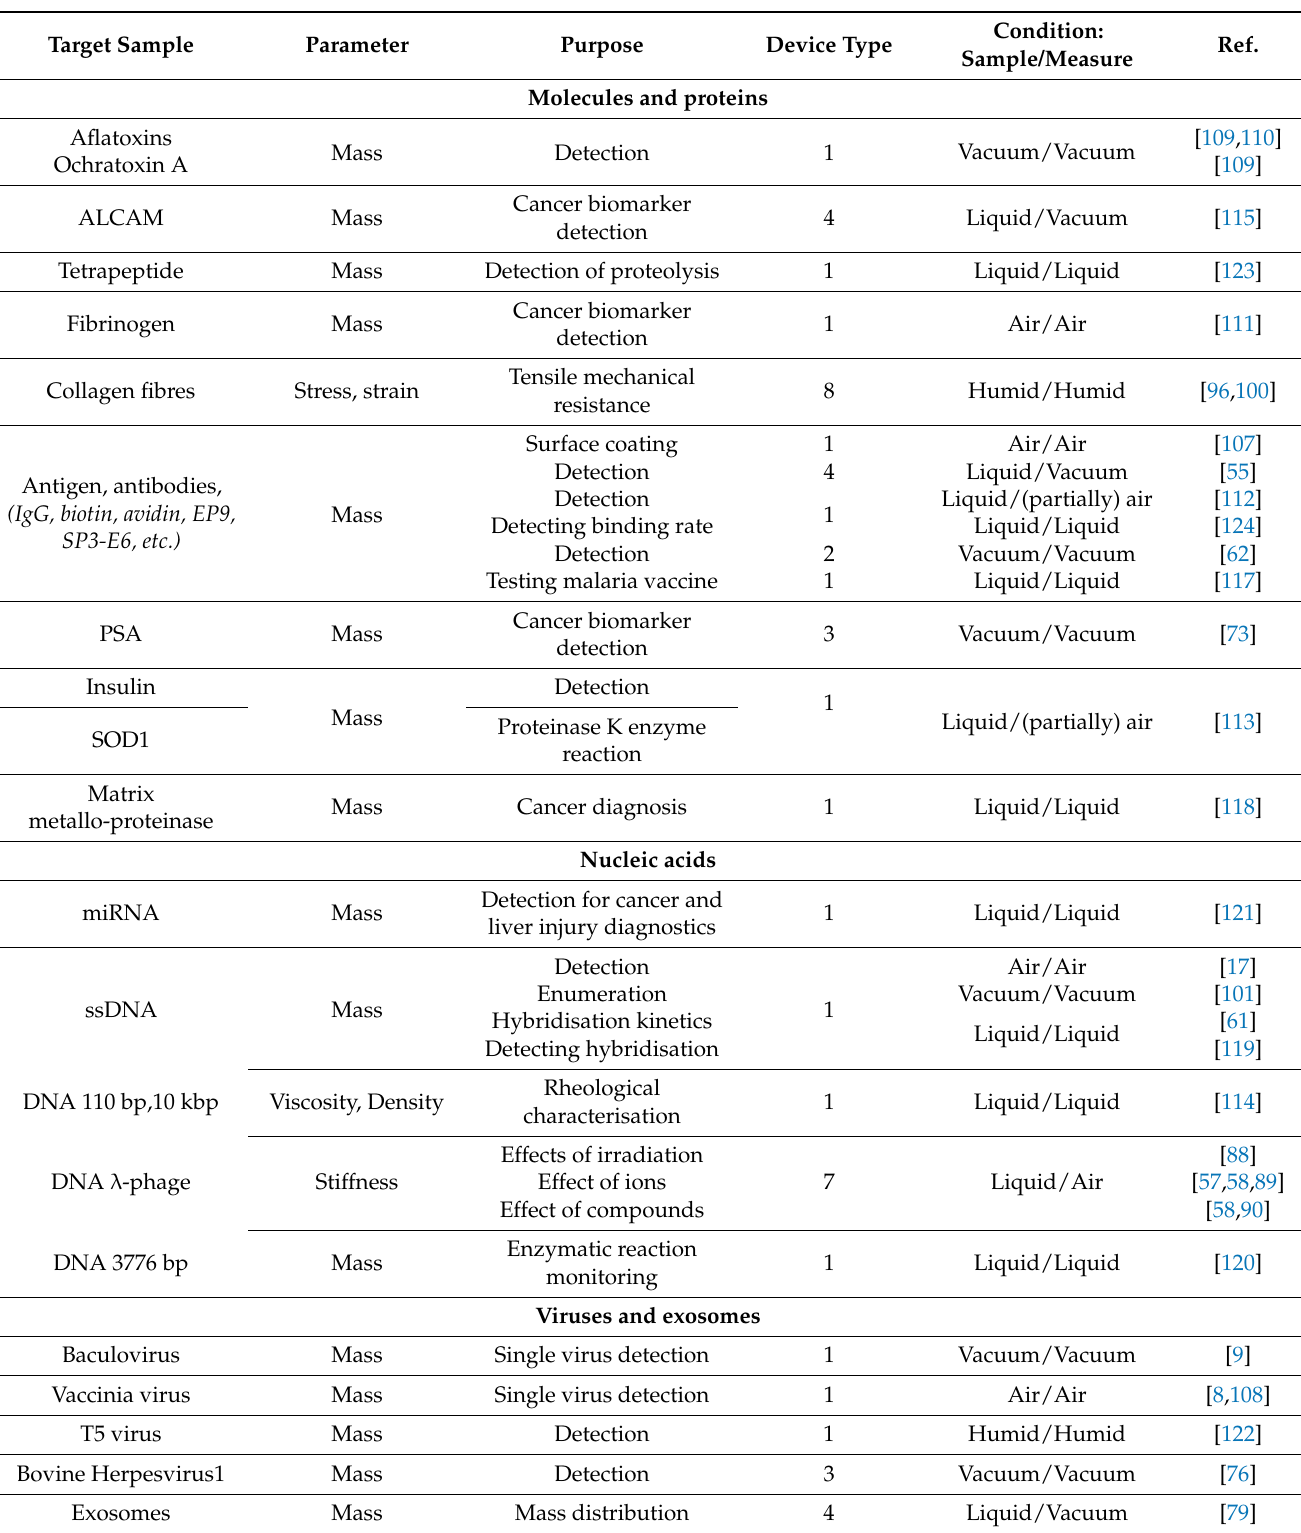
Table 2. An overview of the targeted molecular and subcellular biological samples. The device type column corresponds to the order of the devices introduced in Section 3.1 and Table